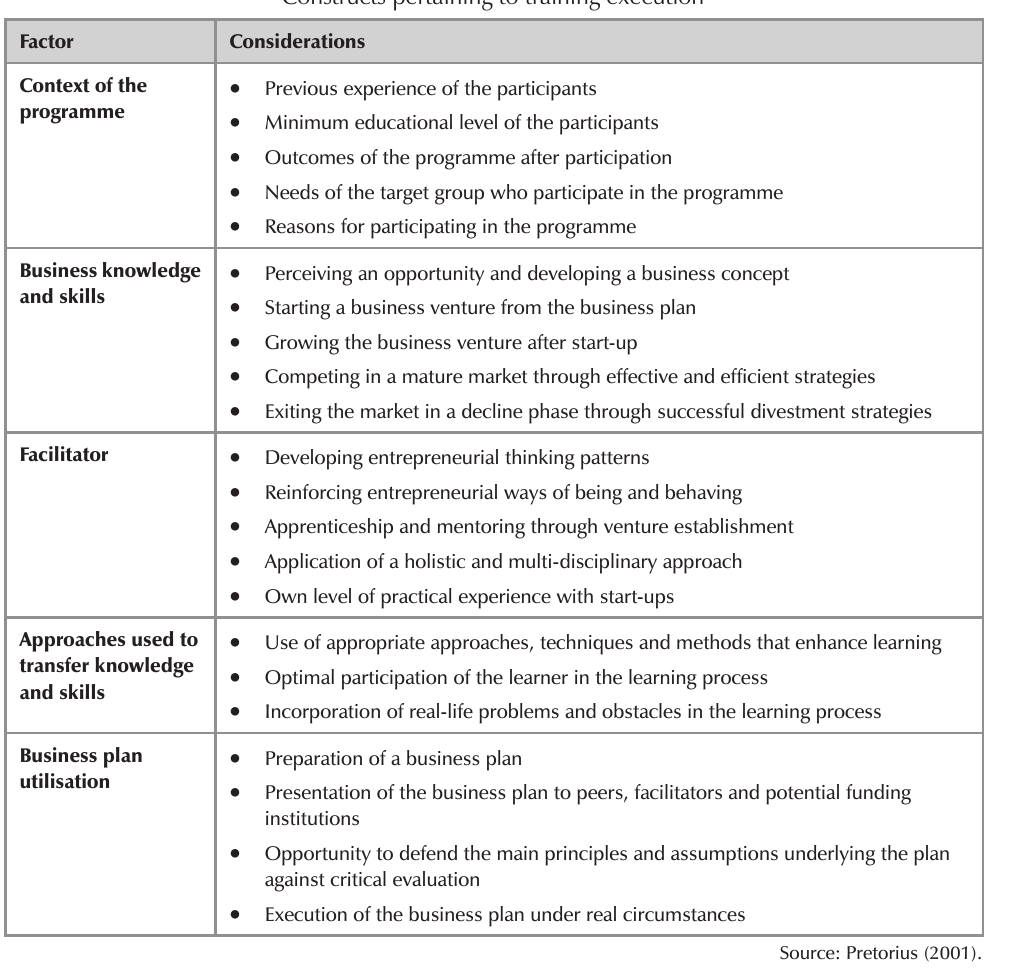
Constructs pertaining to training